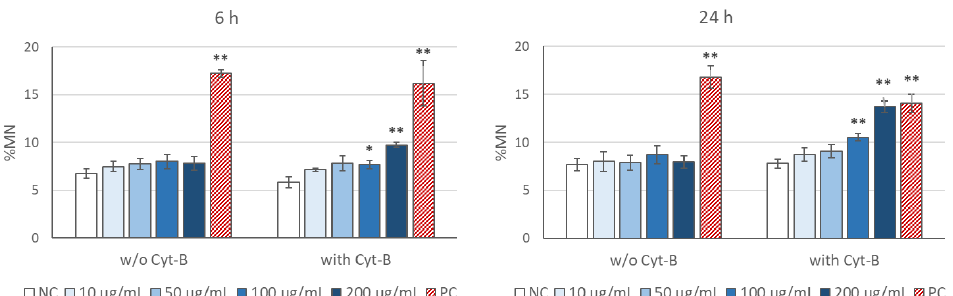
Figure 5. Results of the flow cytometry MN test in SH-SY5Y cells treated with TiO 2 NP for 6 h ( left ) or 24 h ( right ), in the absence or in the presence of cytochalasin-B (Cyt-B). Error bars represent mean standard error. * p < 0.05; ** p < 0.01, significant difference with regard to the corresponding negative control (NC). PC: positive control (MMC: 10 µM for 6 h and 1.5 µM for 24 h treatments).